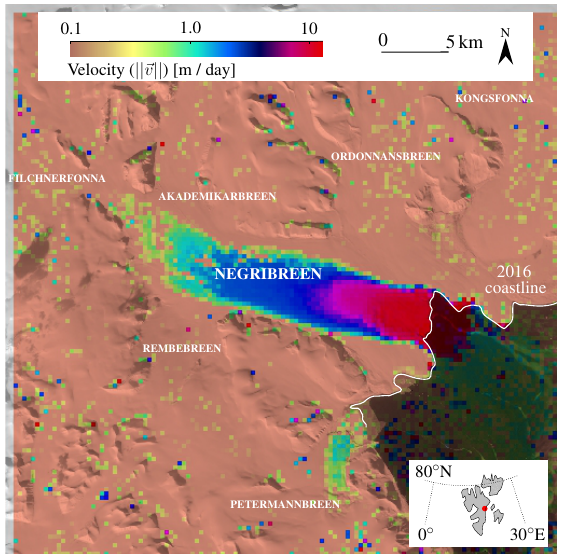
Figure 4. Orthorectification bias ( δh , in equation2) over Negribreen glacier system for April 2018.